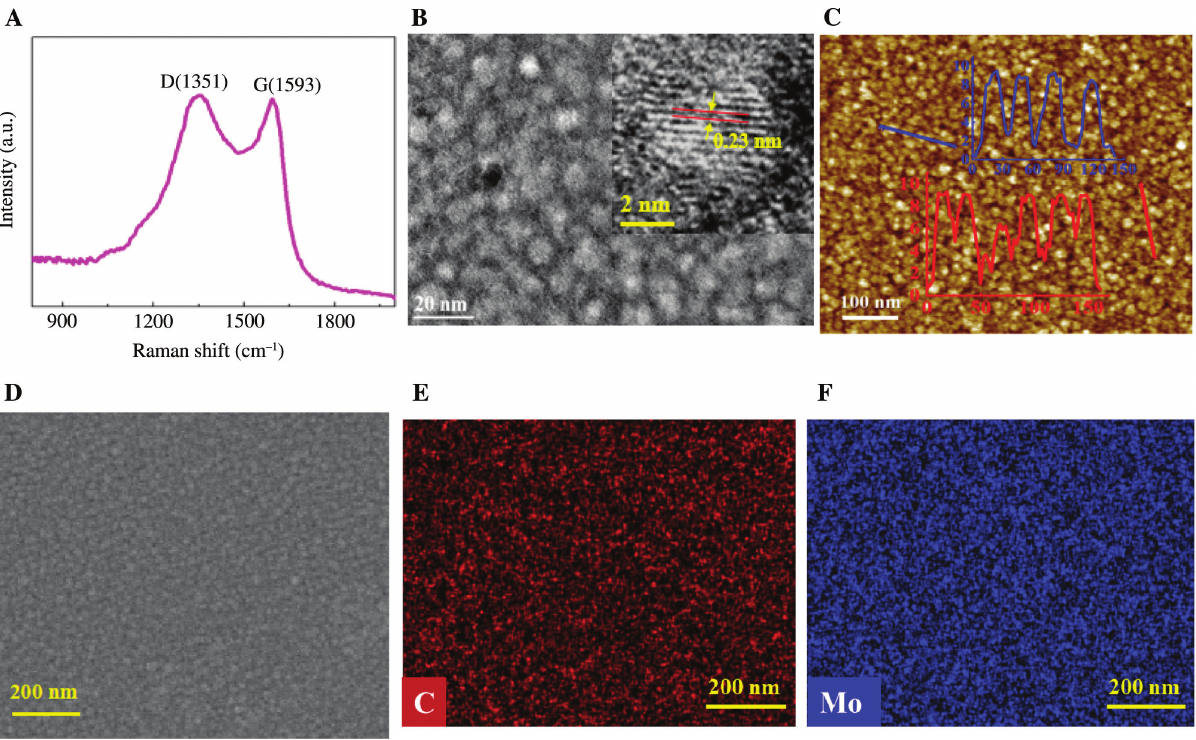
C film. Figure 1: Characterization of Mo 2 (A) Raman spectrum. (B) Low- and high-magnification HRTEM images of Mo C materials. (C) AFM images and height profiles showing the 2 thickness of the 2D Mo C film. (D) SEM images of the Mo C. (E, F) element mapping of C and Mo. 2 2